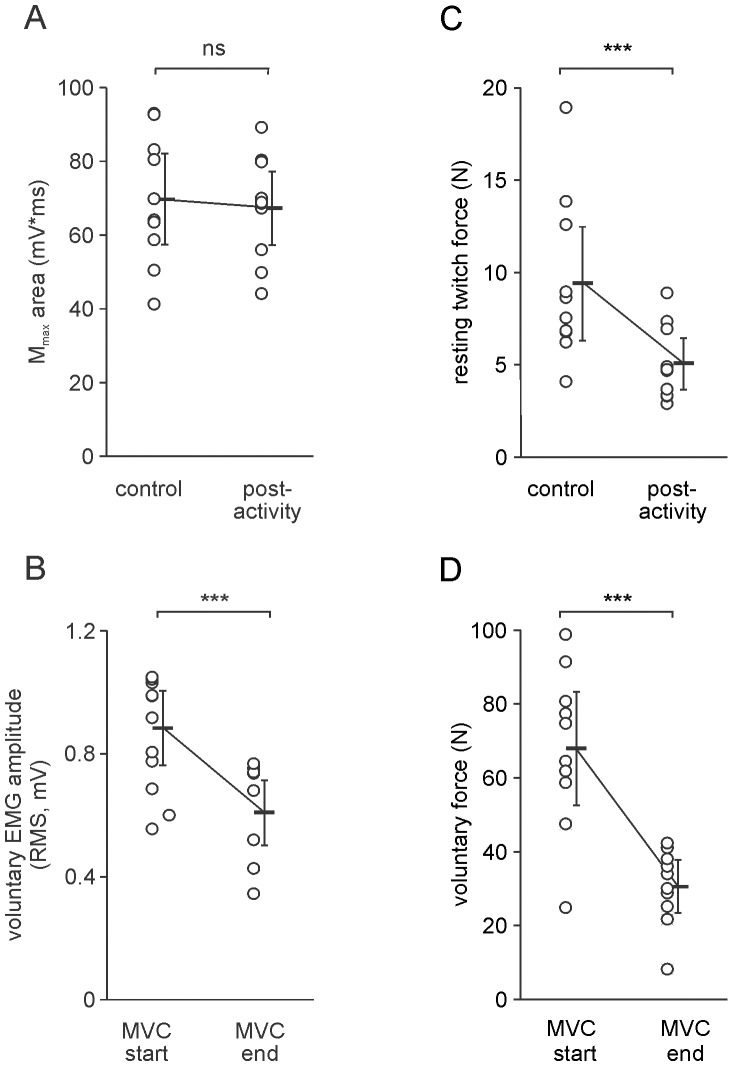
Changes in muscle properties with sustained activity.Open symbols represent the mean for each subject across 5 experimental sessions; pooled data for 10 subjects are shown beside the individual data as mean (solid bars) and 95% confidence intervals. A: there was no change in the area of Mmax after the sustained contraction; B: there was a significant change in the resting twitch force immediately after the 1-min MVC compared to control values; C: the peak amplitude of the voluntary EMG was significantly larger at the start than at the end of the 1-min MVC; D: peak voluntary force was significantly smaller at the end of the 1-min MVC than at the start demonstrating an activity-dependent reduction in the force-generating capacity of the muscle (ie fatigue). ns: not significant; ***: p<0.001.